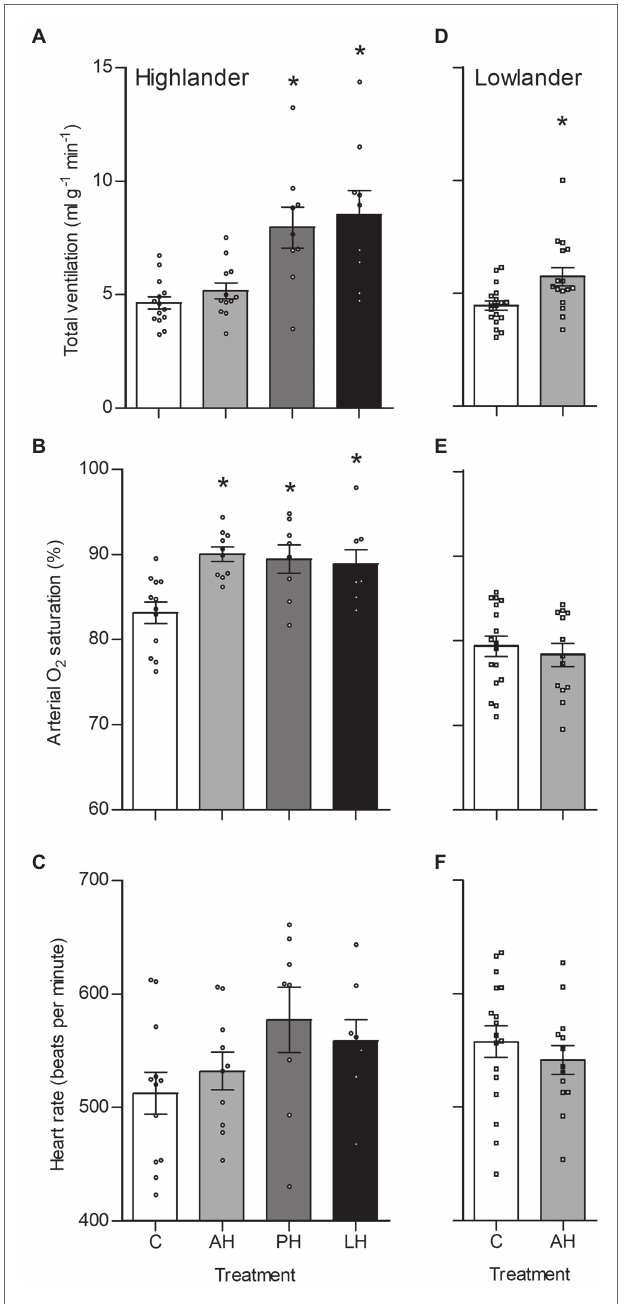
FIGURE 3 | Total ventilation (A,D) , arterial O 2 saturation (SaO 2 ) (B,E) , and heart rate (C,F) measured at thermogenic V ̇ O 2max in hypoxia in highland (A,B,C) and lowland (D,E,F) mice. Lowland mice were unable to raise litters in the PH or LH groups. Bars indicate mean ± SEM and symbols represent individual values. Treatment groups are shown in Figure 1 with N as follows: 14 control (C), 12 acute hypoxia (AH), 9 post-natal hypoxia (PH), and 9 life-long hypoxia (LH) for highlanders; 18 C and 16 AH for lowlanders. *Significant pairwise difference from control within each population using Holm-Sidak post-tests.